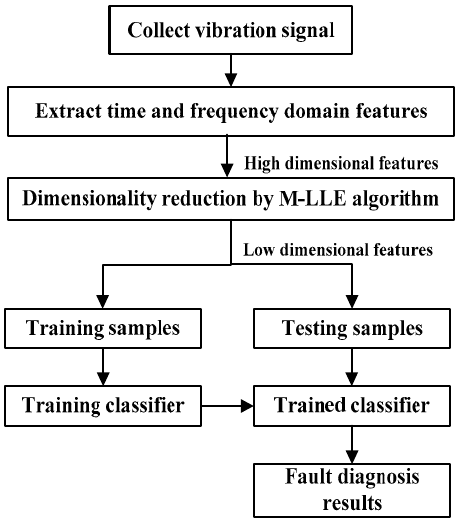
Figure 2. The fault diagnosis model based on M-LLE algorithm.